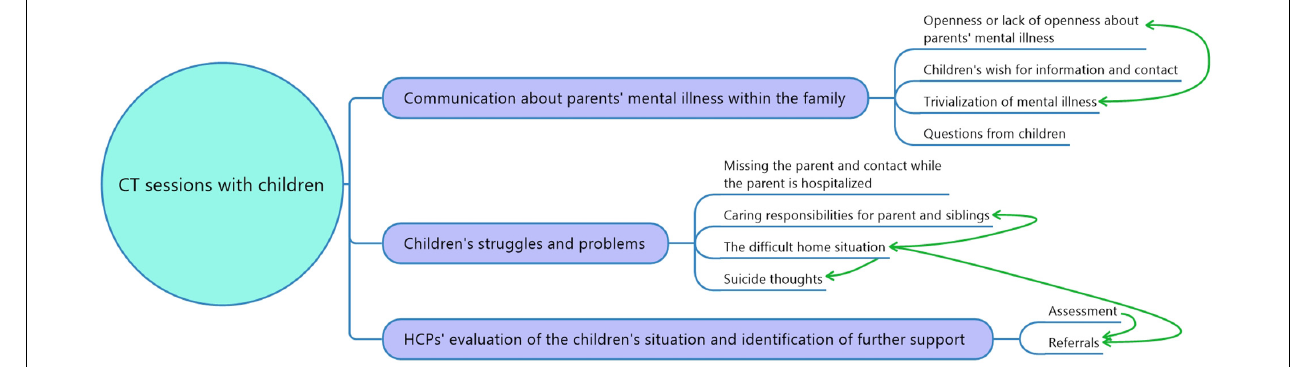
FIGURE 3 | Map over main themes and sub